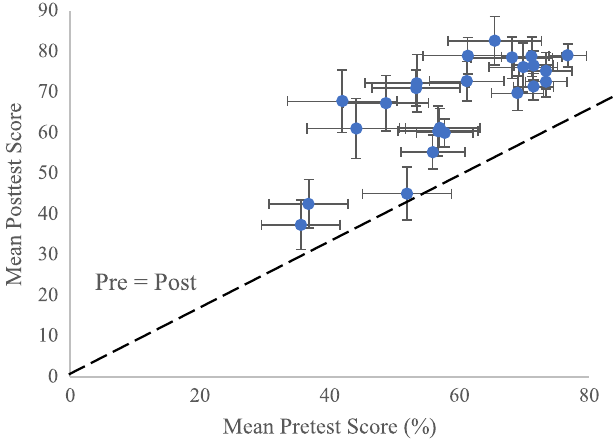
FIG. 1. Mean pretest and post-test scores on GQMA, by item for the 24 continuum-scored items used in this study. Scores are averaged over the 133 student